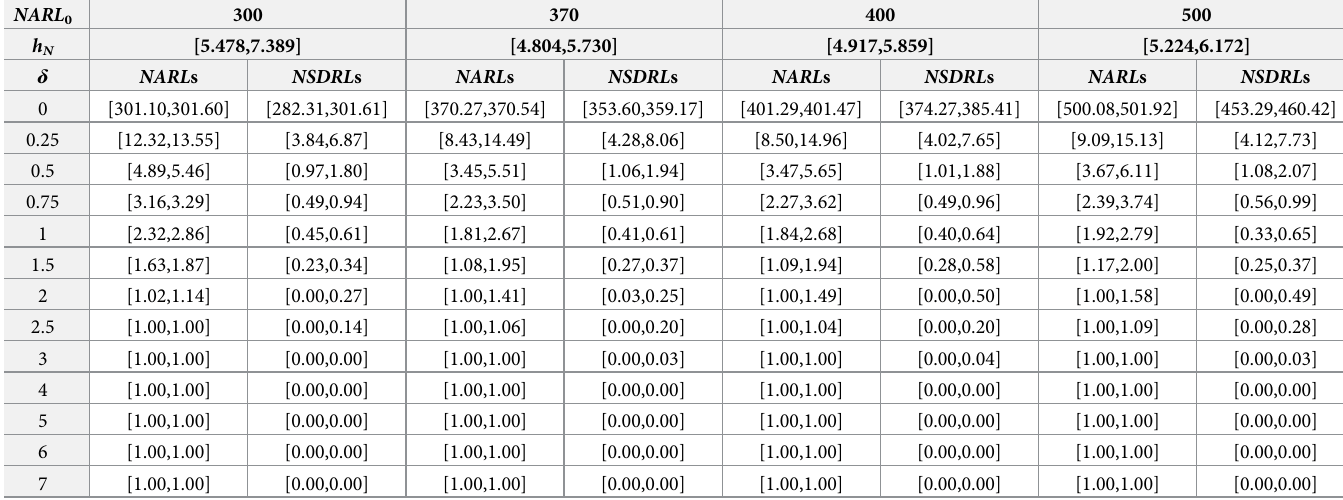
Table 3. The NARL and NSDRL values of the proposed NCUSUM � X chart when n N 2 [10, 20], k N 2 [0.4, 0.5] for different nominal NARL .